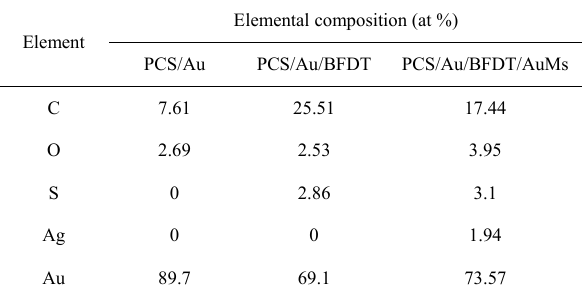
Fig. 3 SEM measured surface morphologies of multimode optical fiber: (a) Au covered fiber surface, (b) after subsequent grafting with BFDT, and (c) grafting of AuMs with sharp edges. Table 1 Surface elemental composition (measured by SEM-EDX) on the Au coated optical fiber, Au coated optical fiber grafted with BFDT, and Au coated optical fiber with grafted